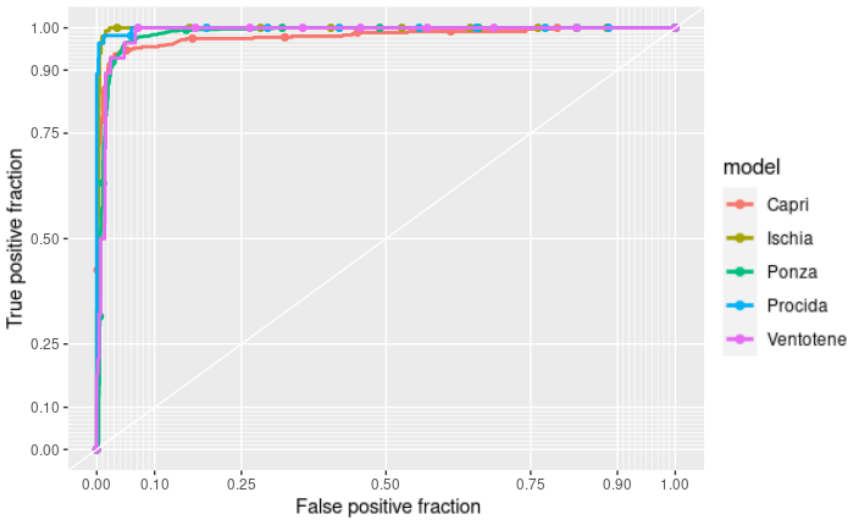
Figure 6. ROC Curves. Table 6. The